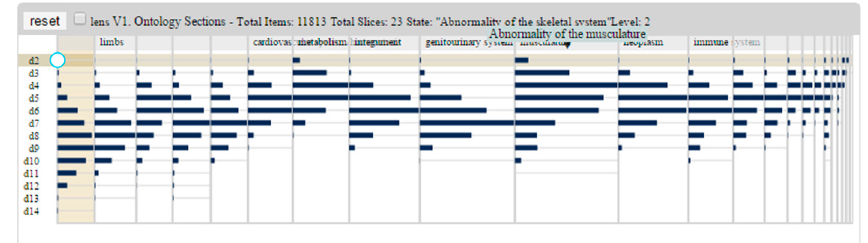
Figure 21. Adjusting the scaling of the Ontology Sections Panel subview to enlarge the “Abnormality of the Musculature” section, which is normally represented as a much smaller portion of the visual space.